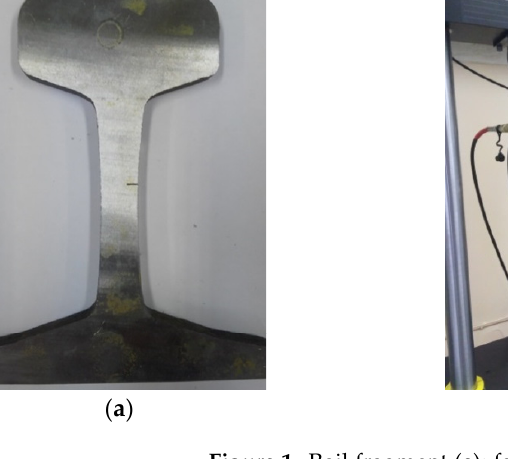
Figure 1. Rail fragment ( a ); fatigue crack growing in Instron 8801 testing machine ( b ); test of